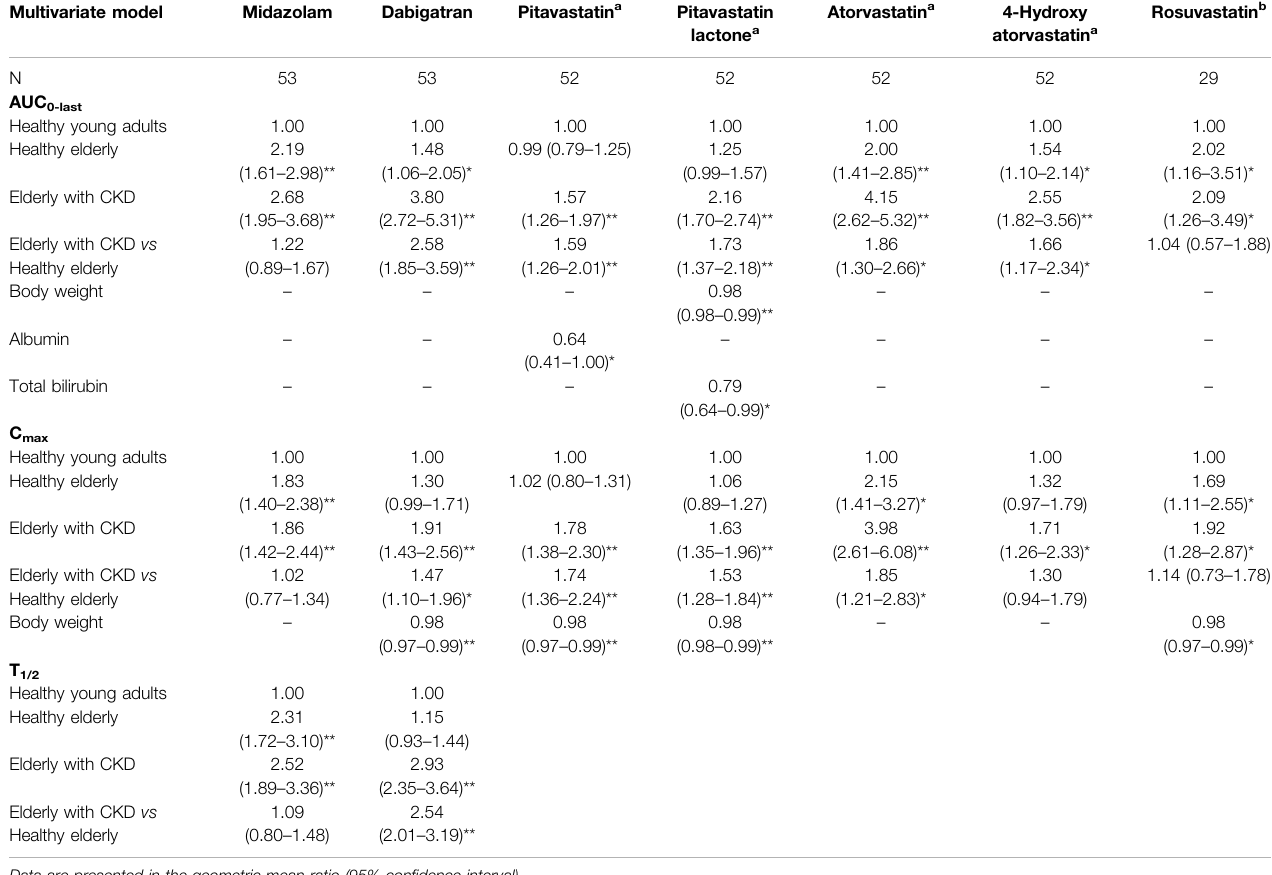
TABLE 5 | Multivariate analysis of the differences in AUC 0-last , C max , and T 1/2 between three groups of participants. Multivariate